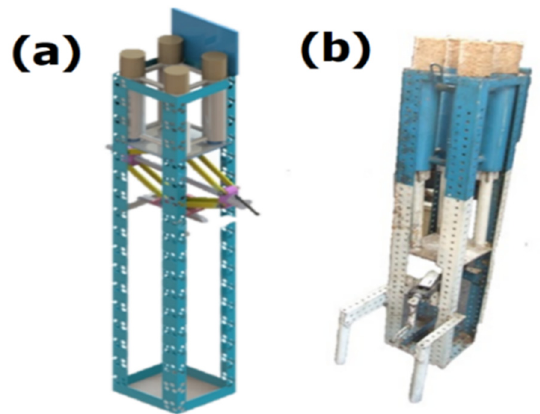
Figure 2. Mechanical system for briquette production: ( a ) computer design; ( b ) the finished apparatus.